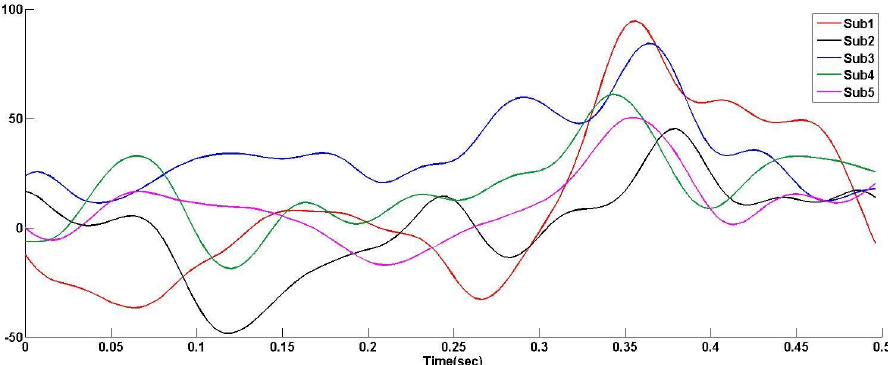
Figure 7. P300 potentials of five subjects obtained from the EEGs of 10-round intensification process recorded at Pz.